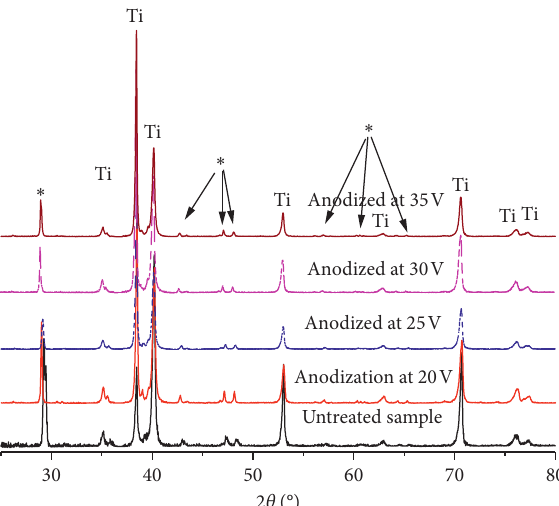
Figure 4: X-ray diffraction of anodized titanium in phosphoric acid 5M obtained at different voltages for 2min. ∗ Sample carrier.